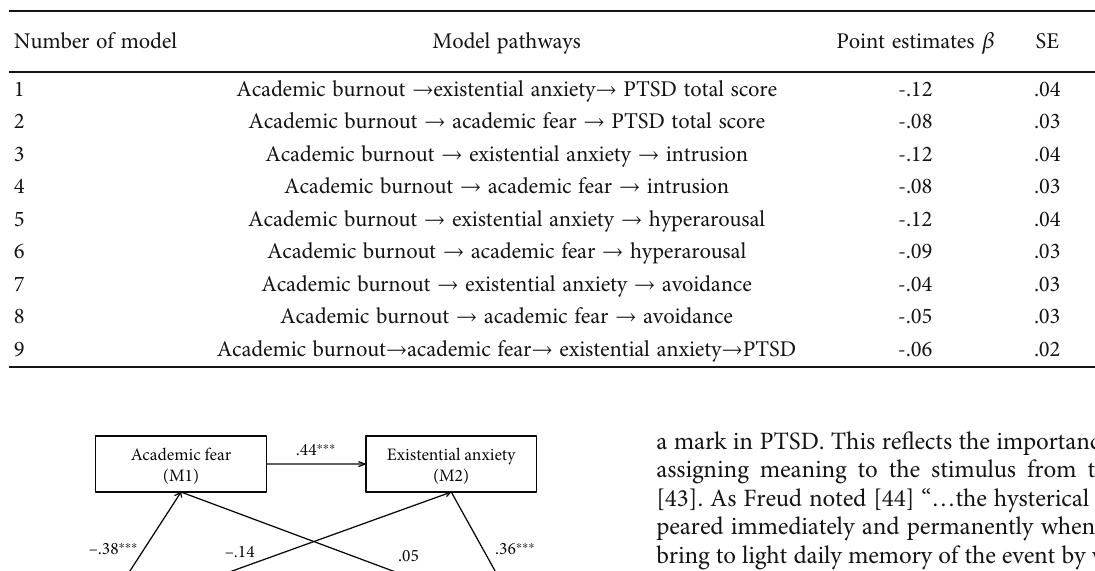
Table 5: Indirect e ff ects of tested models.